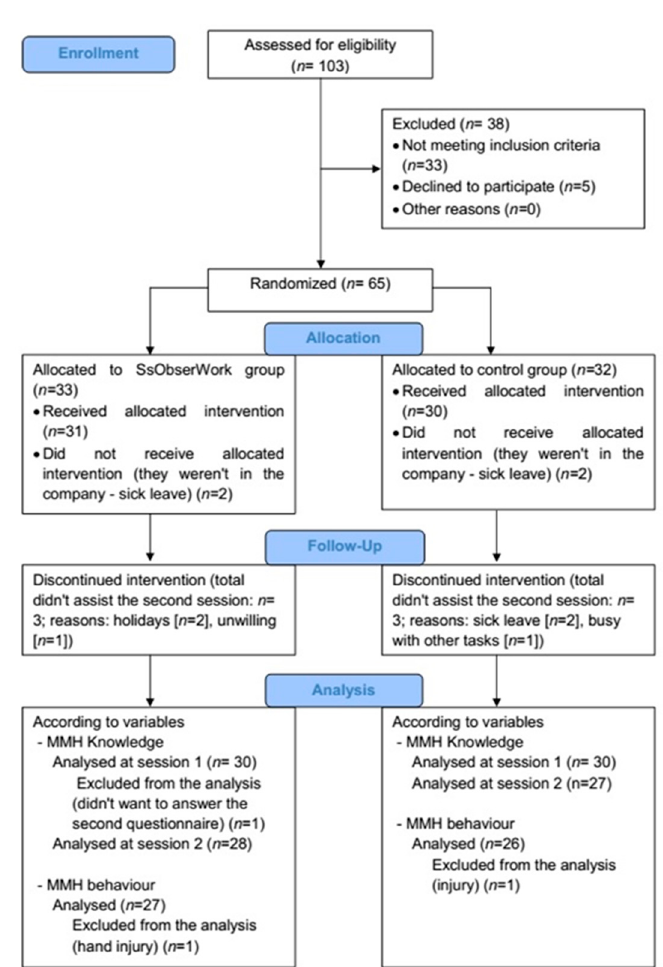
Figure 1. Consort flow diagram.